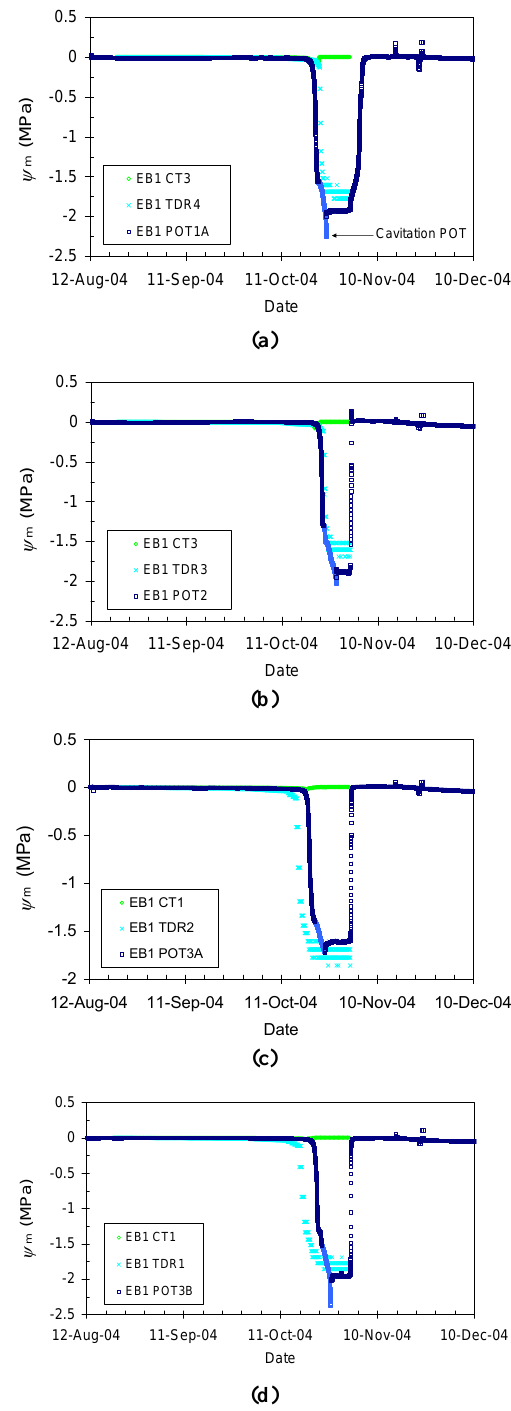
Fig. 4. Development of the matric potential ψ m in time measured by polymer tensiometers (POT), time domain reflectometry probes (TDR) and water-filled tensiometers (CT) in evaporation container 1 (EB1) that was filled with sand. Each sub-figure shows a POT- TDR pair installed opposite to one another, and the nearest